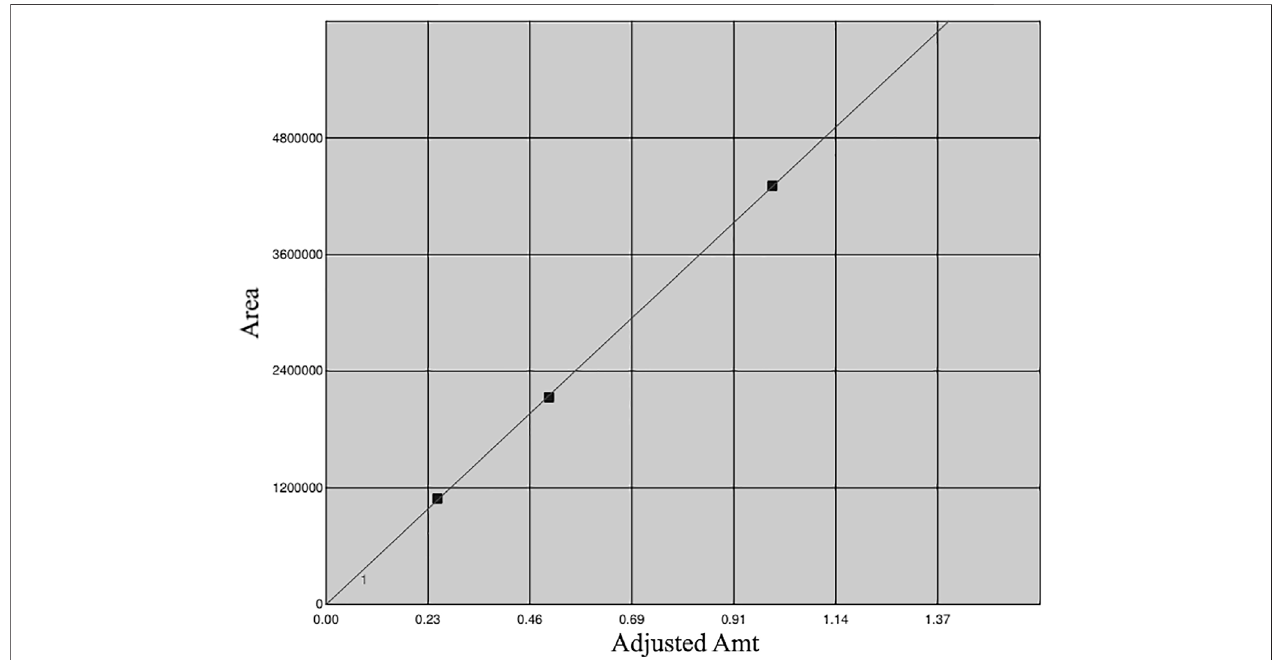
FIGURE 1 | Calibration curve of galangin generated using 0.25, 0.50 and 1.00 mg/ml.